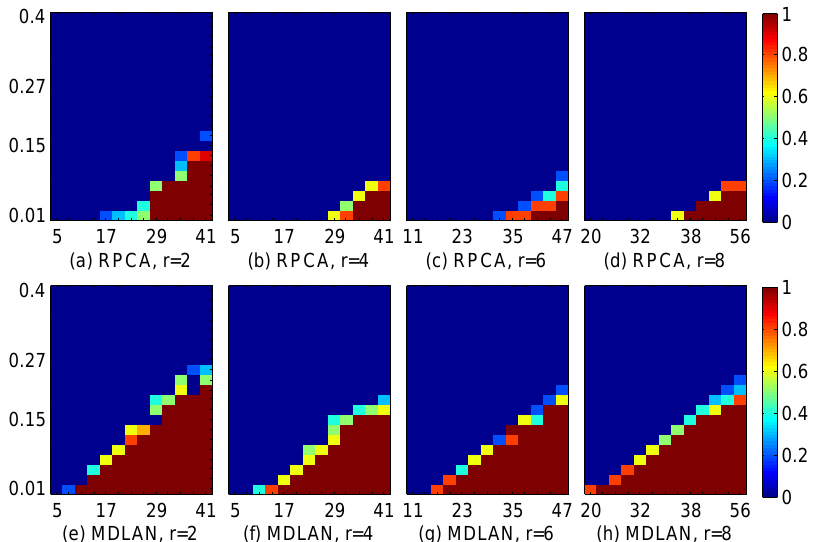
Figure 2. Recovery results with various numbers of observations ( n ). Comparison of robust principal components analysis (RPCA) and the proposed minimum description length atomic norm (MDLAN) method for rank 2, 4, 6 and 8 cases. The X -axis represents the number of samples ( n ) and the Y -axis represents the corruption ratio p ∈ [ 0.01,0.41 ] . The color magnitude represents the success ratio [0,1].